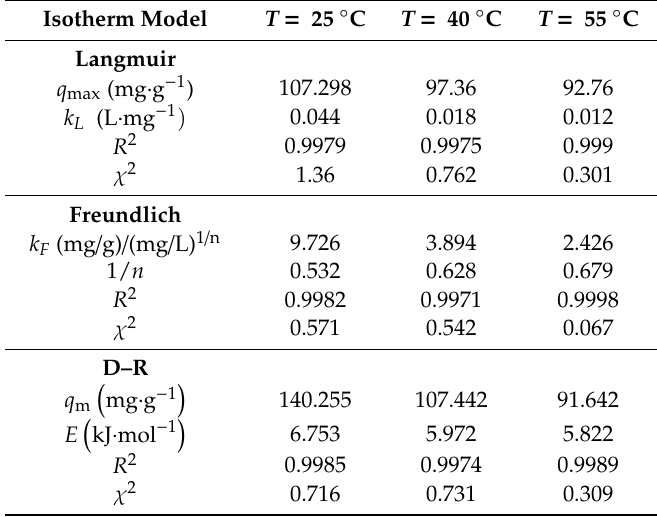
Table 5. Parameters of isotherms models for the adsorption of MO on adsorbent Mn–mica. Isotherm